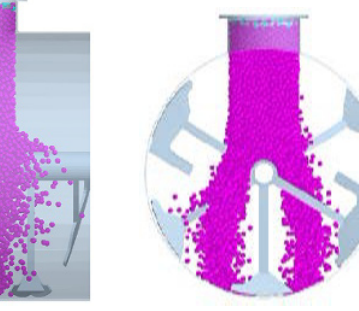
6(a) Snapshot at